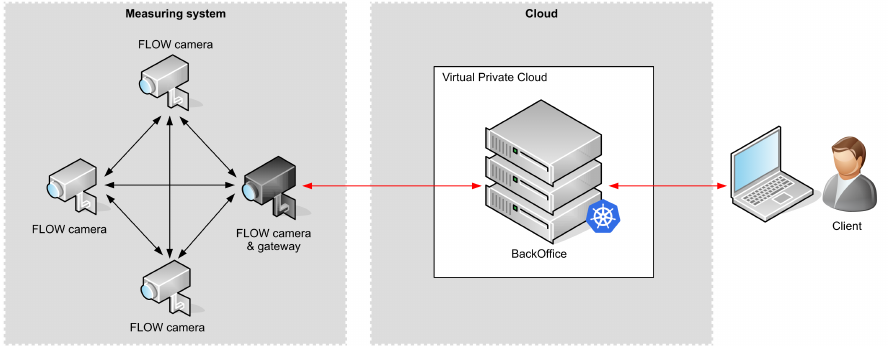
Figure 1. High level architecture of the vehicle tracking system. Black and red arrows denote local and global communication